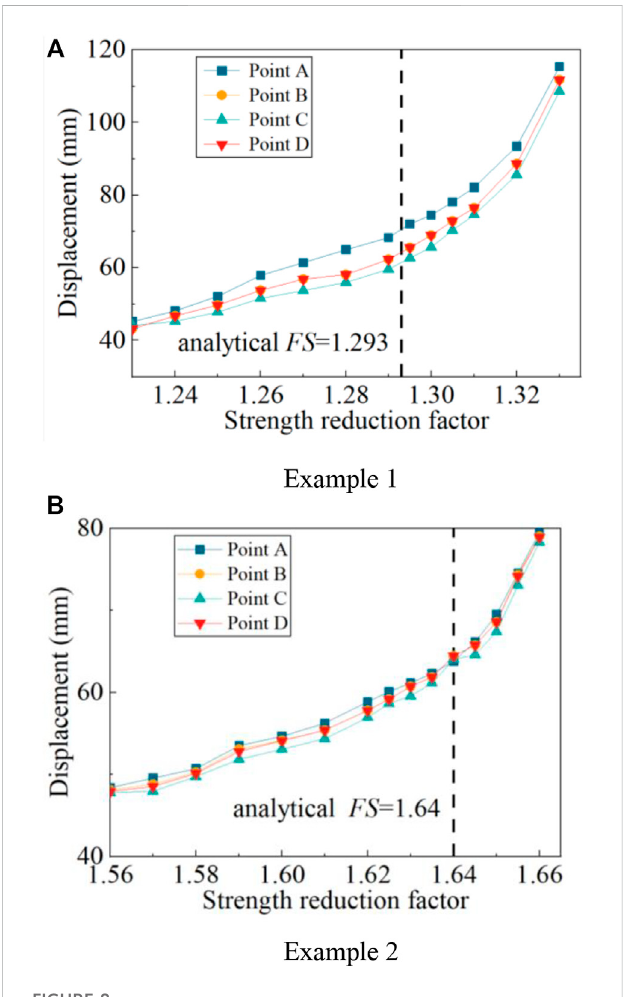
FIGURE 8 Displacement of speci fi c points with the rise in the strength reduction factor. (A) Example 1 (B) Example 2. FIGURE 9